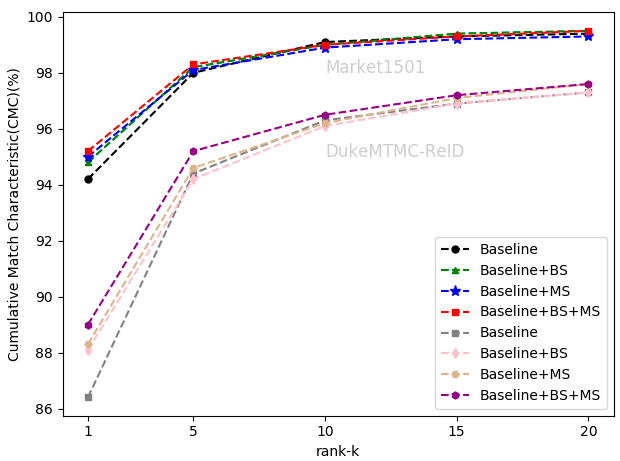
Figure 6. The CMC curve on Market1501 and DukeMTMC ‐ ReID.